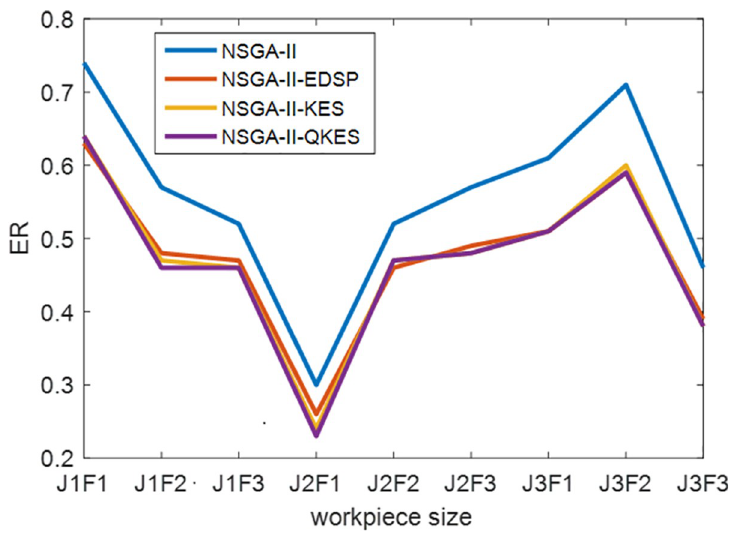
Fig 5. Algorithm comparison